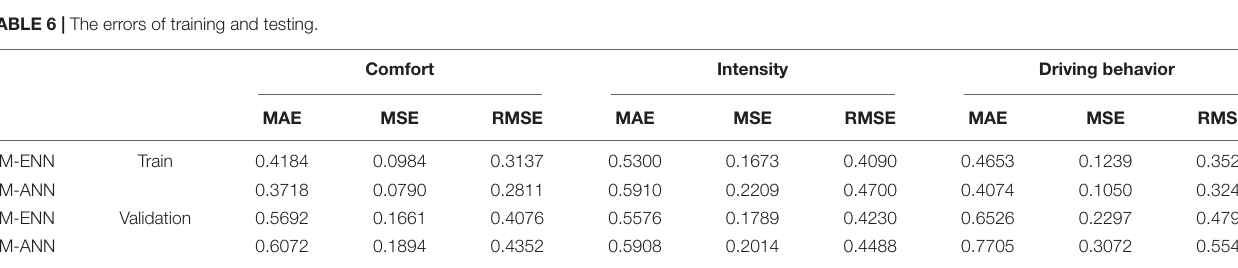
TABLE 6 | The errors of training and testing.